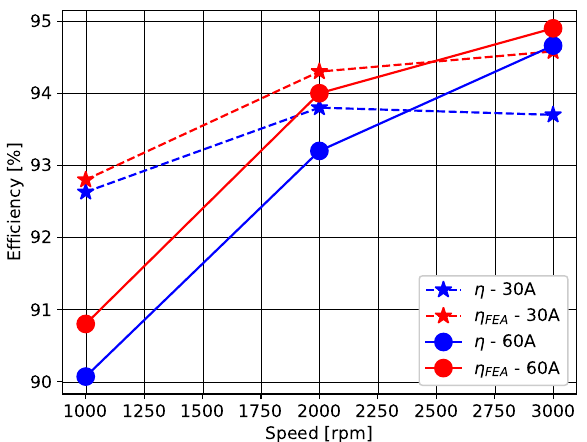
Figure 16. Measured and simulated efficiency comparison. η is measured efficiency, η FEA is efficiency established with